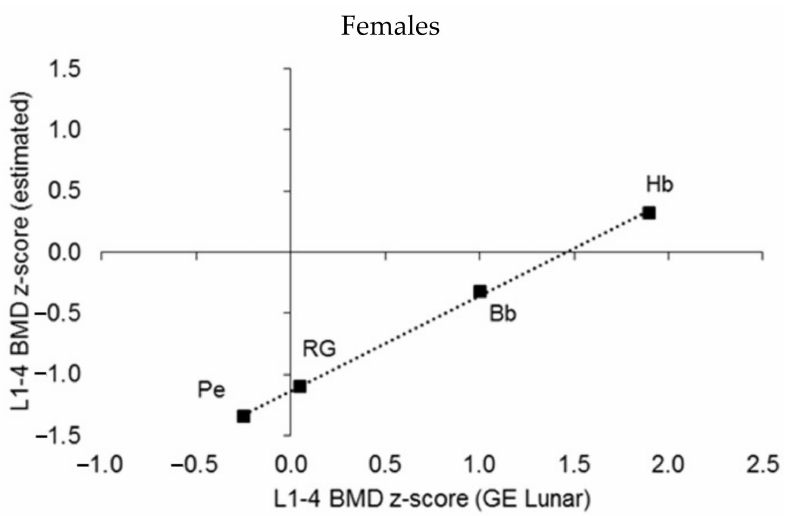
Figure 9. Median L1–L4 BMD z-scores estimated by sport by using the GE Prodigy Lunar reference and the youth athlete reference (Kalabiska et al. 2020); linear regressions: males p < 0.001, R2 = 0.991, intercept = − 0.59, females p < 0.001, R2 = 0.999, intercept = −